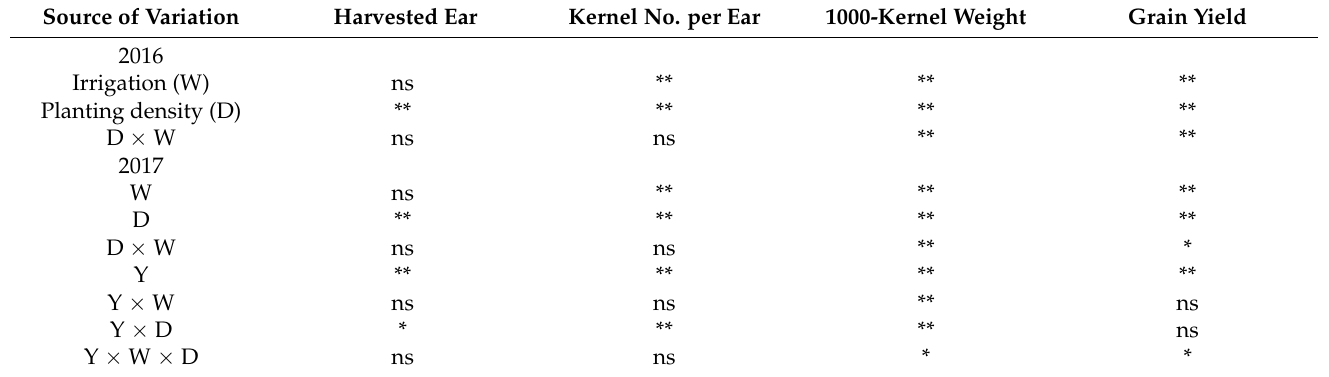
Table 2. Levels of significance in an analysis of variance (ANOVA) for the main factors, which included irrigation level and planting density and the two-way interactions between harvested ear, kernel no. per ear, 1000-kernel weight, and grain